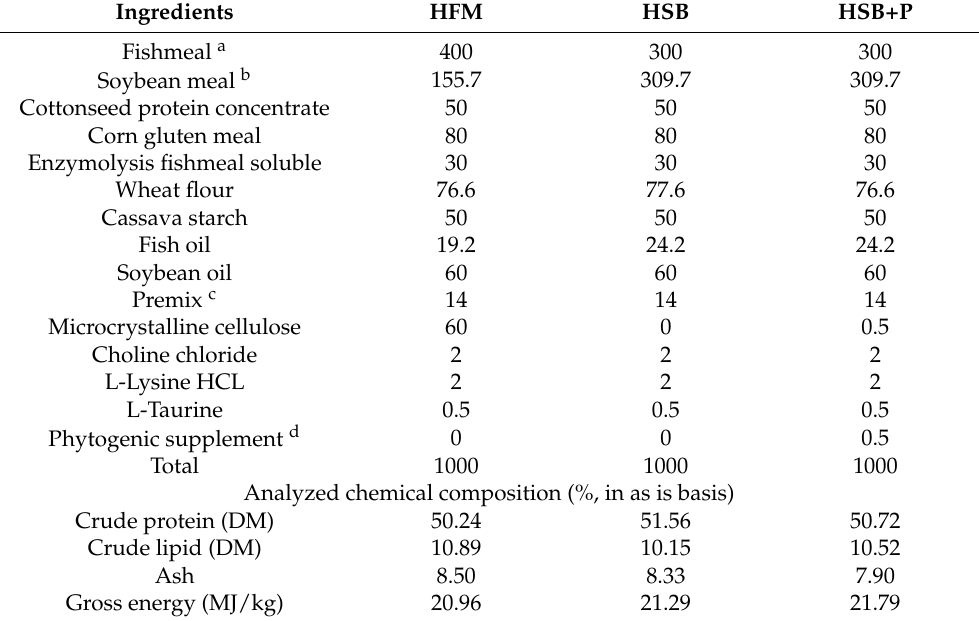
Table 1. Formulation and compositions of experiment diets